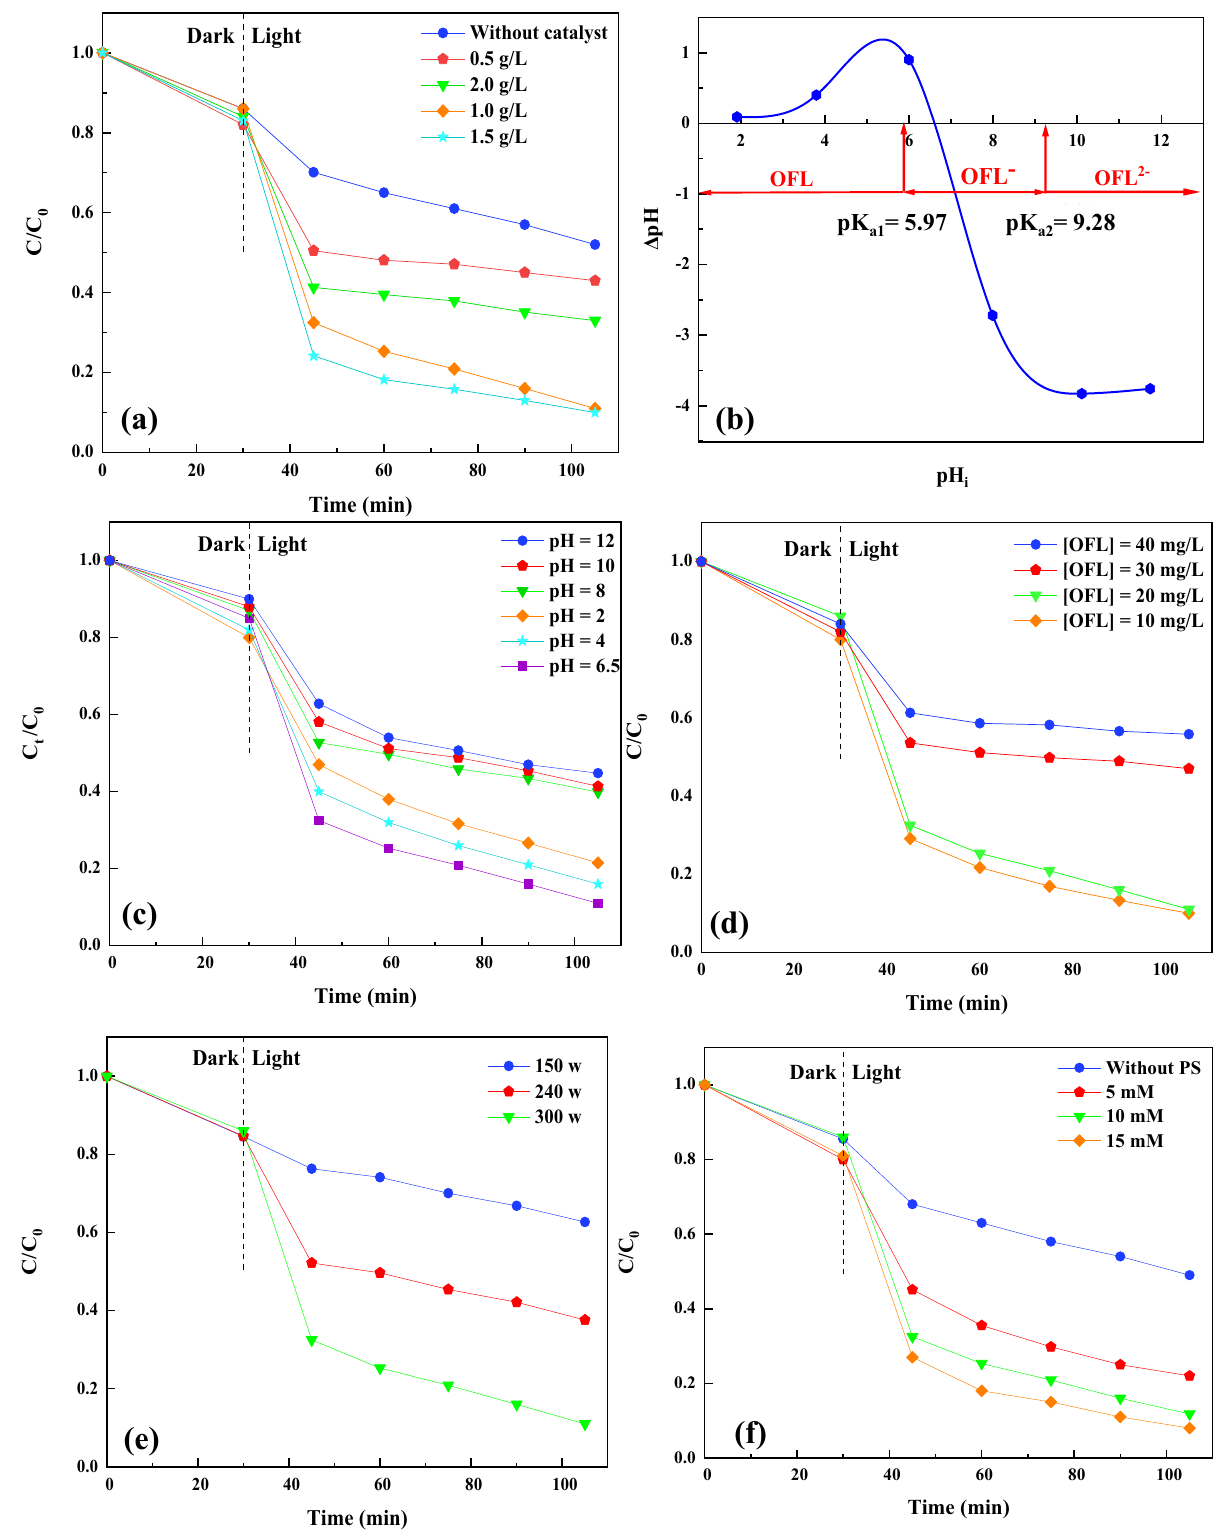
Fig. 5 Effect of different operating parameters on the degradation ef fi ciency of OFL. a Effect of catalyst concentration, c the effect of initiate pH, d various OFL concentrations, e bath ultrasonic power, and f persulfate concentration on the piezo-photocatalytic degradation of OFL. b pH pzc of BaTiO 3 / WS 2 nanocomposite. Experimental conditions: Catalyst concentration = 1.0 g L − 1 , [OFL] = 20 mg L − 1 , [PS] = 10 mM, pH = 6.5. The error bars were not shown, as they were smaller than the data